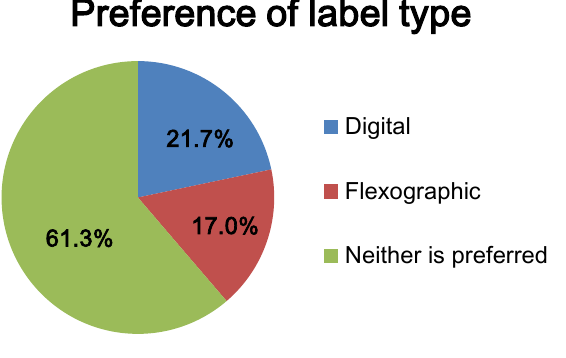
Figure 3. Response to post survey question on label